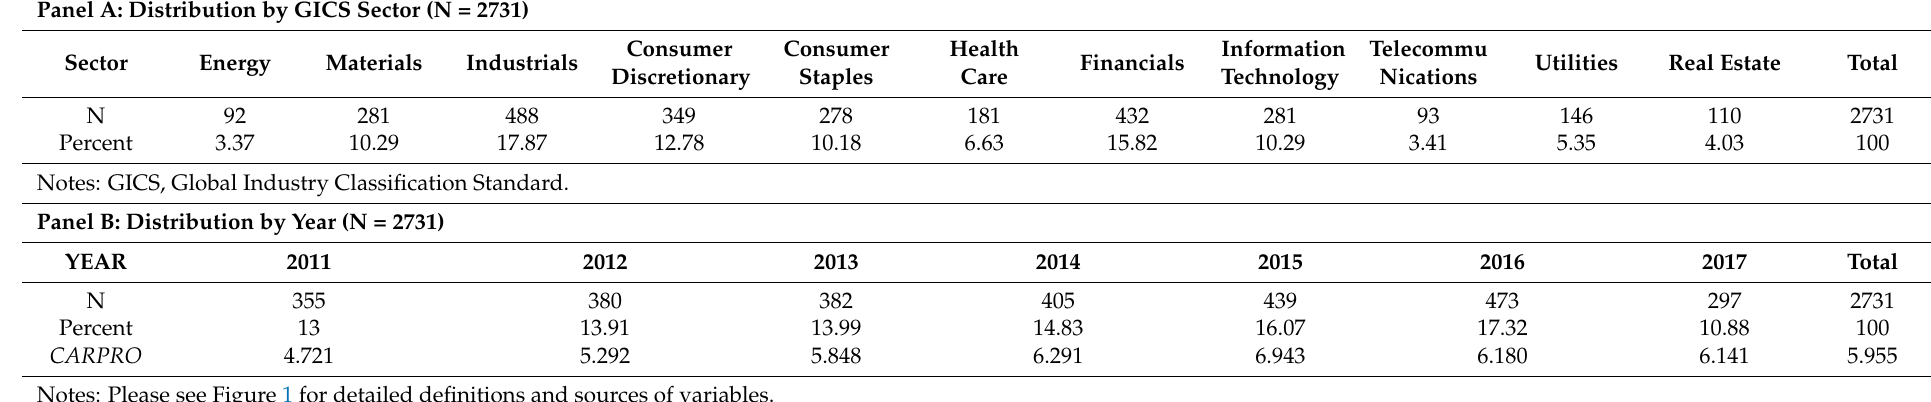
Table 4. Distribution of the Sample by Sector, Year, and